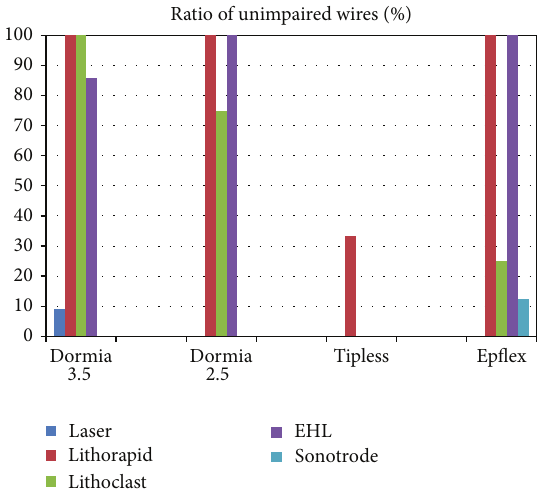
Figure 9: Over all the four basket types, the tipless 1.8CH basket has the lowest resistance.